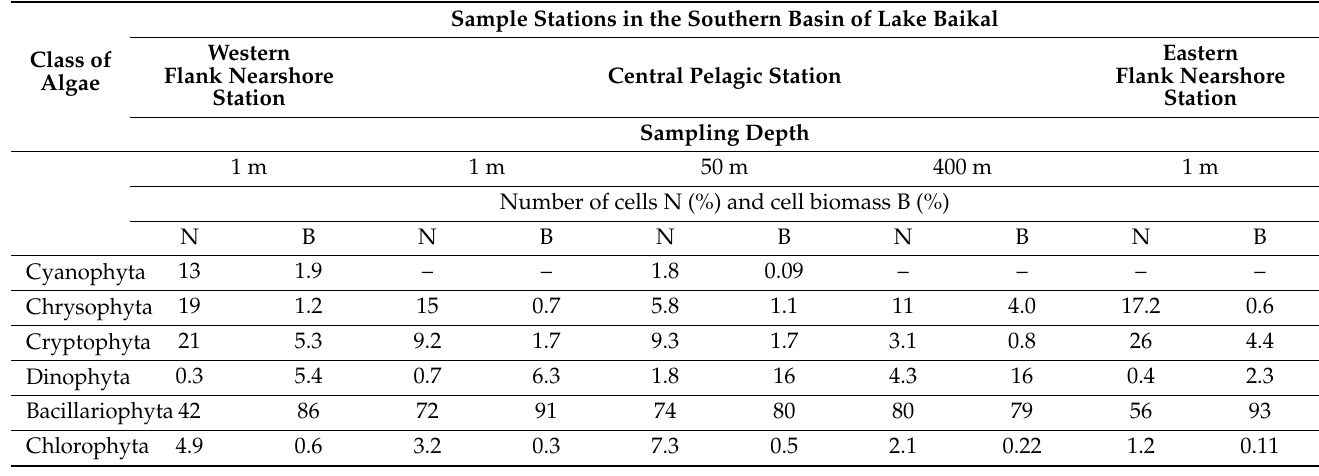
Table 2. Contribution of Bacillariophyta to total phytoplankton biomass during spring season (2020).